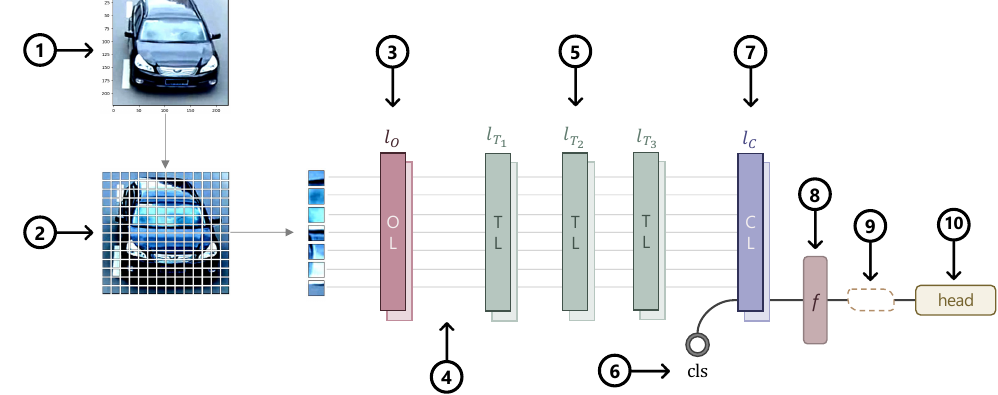
Figure 8. Illustration of V 2 ReID using Vision Outlooker as the backbone. The numbers denote each step: from splitting the input image into fixed-size patches, to feeding the patches in VOLO, to classifying the input